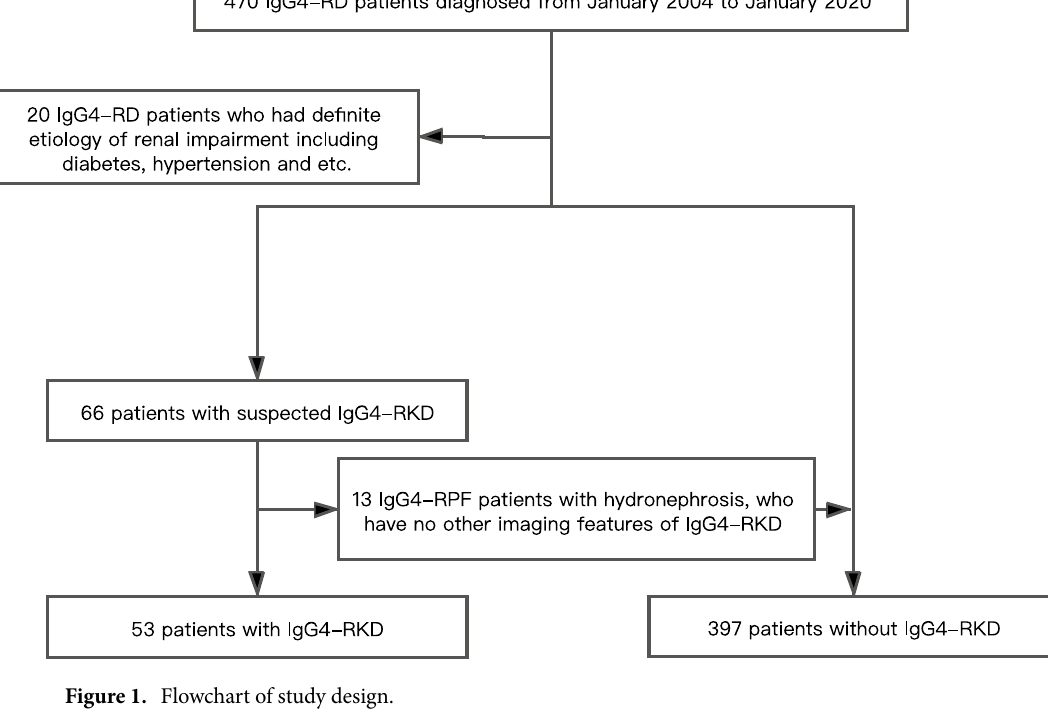
Figure 1. Flowchart of study